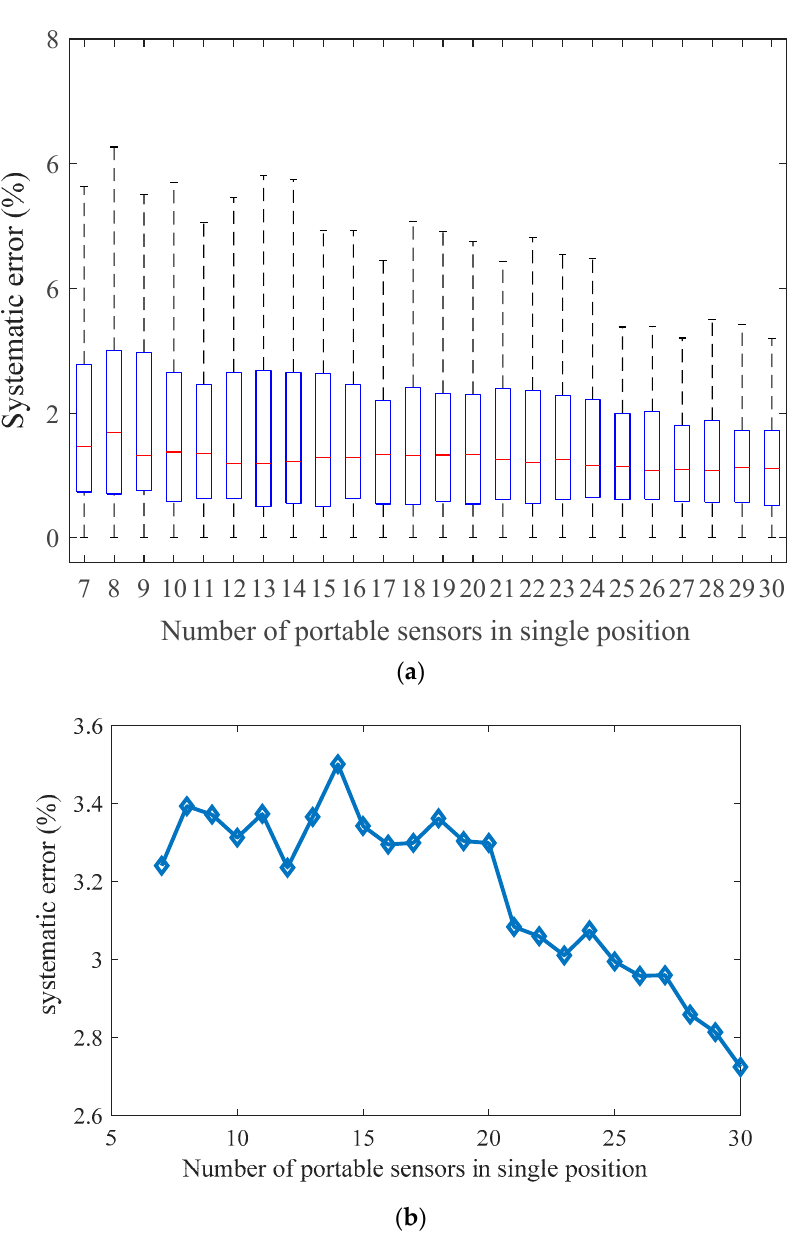
Figure 16. Trustworthiness and average systematic error of Algorithm 1. ( a ) Trustworthiness, ( b ) Average systematic error.